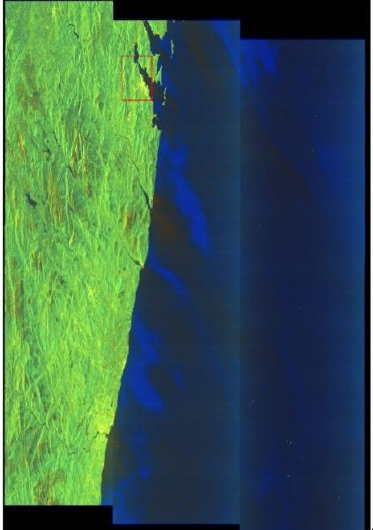
Figure 3 . Full coverage of the master image downloaded for processing in SNAP. In the red box, the site of the city of Vigo, which will only be used as a study area in StaMPS program.